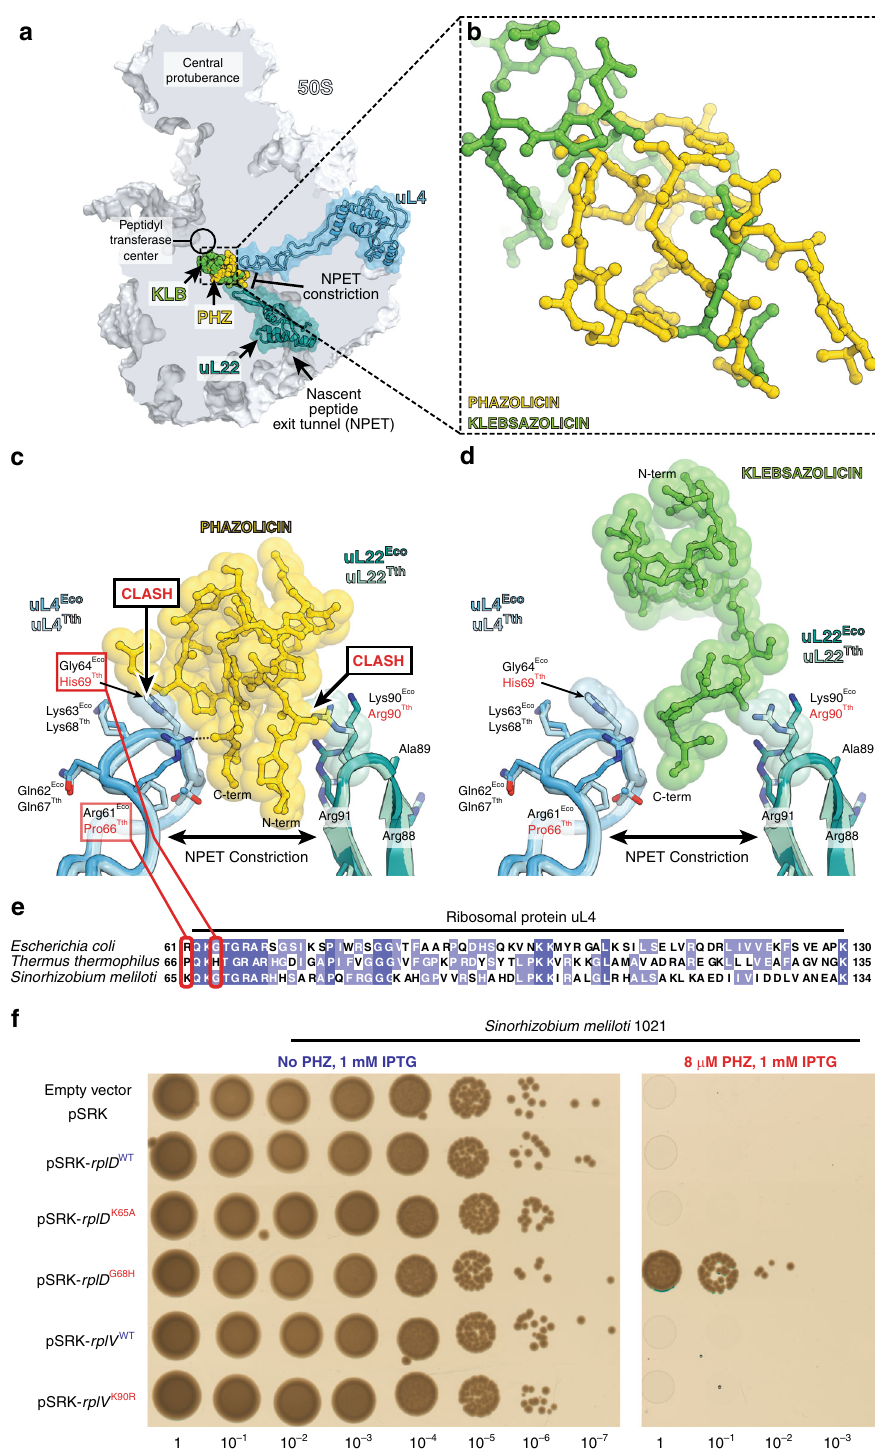
Fig. 5 The loop of ribosomal protein uL4 de fi nes species-speci fi city of PHZ action. a Comparison of PHZ (yellow) and KLB (green) binding sites in the ribosome exit tunnel. The 50S subunit is shown in light blue. Ribosomal proteins uL4 and uL22 are highlighted in blue and teal, respectively. b Superposition of the ribosome structures with bound KLB (PDB entry 5W4K 8 ) and PHZ based on the alignment of the 23S rRNAs. Ribosome parts are omitted for clarity. Note that KLB binds closer to the PTC than PHZ. c , d Close-up view of PHZ c and KLB d interactions with the loops of proteins uL4 and uL22 forming the NPET constriction site. Superposition of the loops of proteins from E. coli and T. thermophilus is shown. Note that sterical clashes occur only with the side chains in the loops of proteins uL4/uL22 from T. thermophilus . e Multiple sequence alignment of the homologous parts of the ribosomal protein uL4 from several bacterial species. Red boxes highlight the amino acid residues of uL4, which either clash with the PHZ (His69 in Tth ) or interact with it in our structure (Arg61 in Eco ). f Growth of S. meliloti Sm1021 and its derivatives expressing plasmid-borne copies of WT or mutant rplD or rplV genes (encoding ribosomal proteins uL4 and uL22, respectively) on agar plates without PHZ (left panel) or with 8 μ M PHZ (right panel). Note that only overexpression of Tth-like version of uL4 protein in S. meliloti confers resistance to